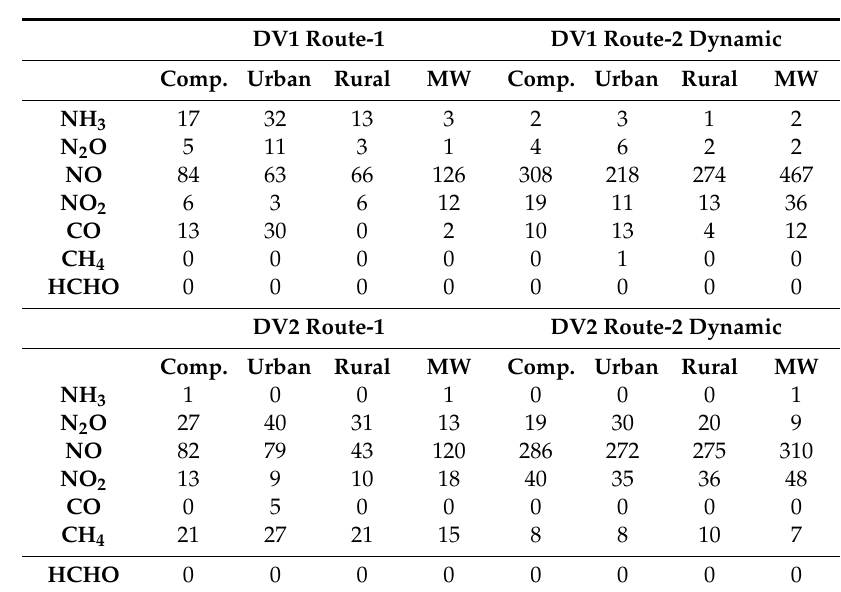
Table 4. NH 3 , N 2 O, NO, NO 2 , CO, CH 4 , and HCHO emissions factors (mg / km) obtained for the DV1 and the DV2 during the two tests performed for each vehicle along Route-1 and Route-2. Both vehicles were tested on a dynamic driving on Route-2. Emission factors (mg / km) are presented for the complete routes (Comp.), and the urban, rural and motorway (MW)